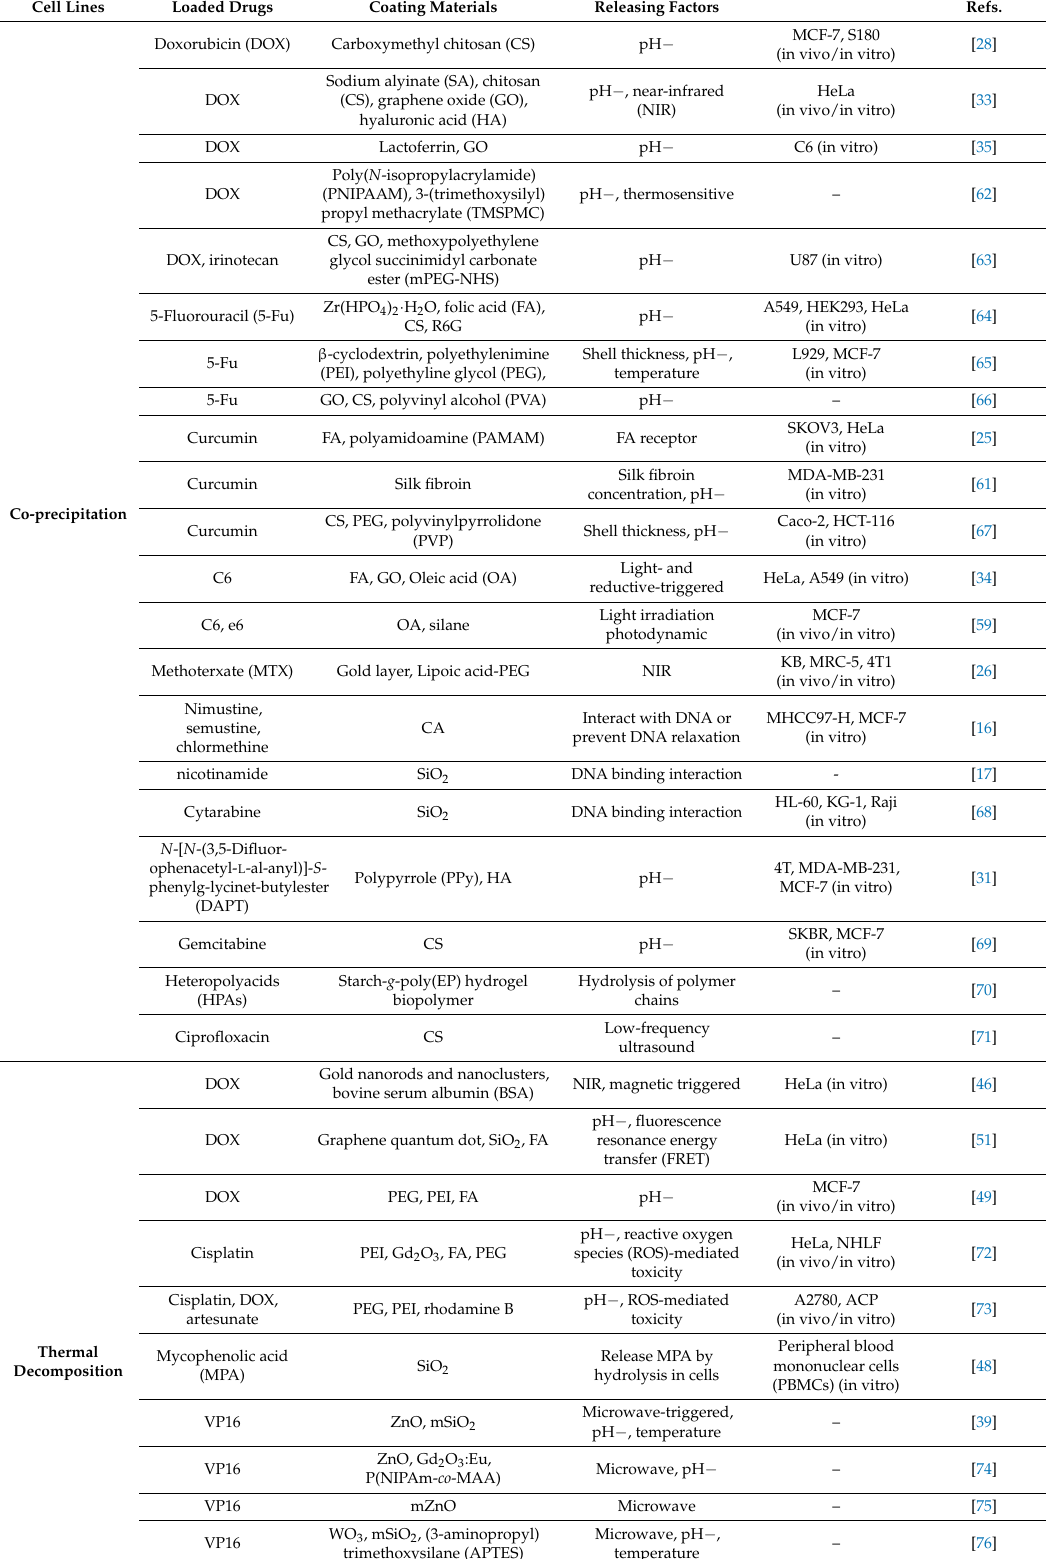
Table 1. Functionalization of Fe 3 O 4 NPs with different coatings for targeted drug delivery. Cell